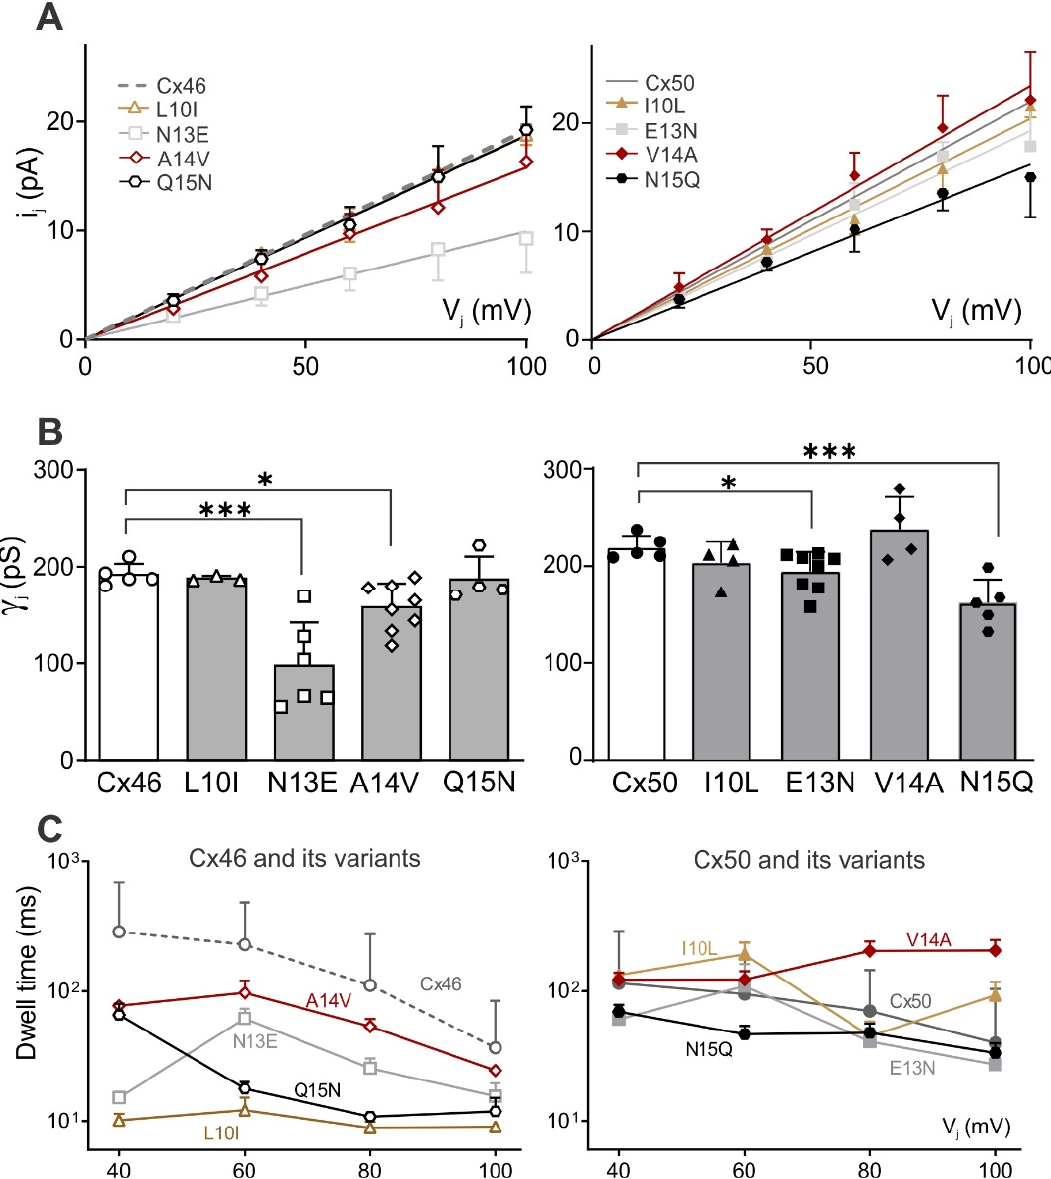
Figure 8. Unitary channel properties of homotypic GJs of Cx46 L10I, N13E, A14V, Q15N and Cx50 I10L, E13N, V14A, N15Q variants. ( A ) Plot of averaged i j amplitudes at the main open state for the tested V j s. Linear regression was used to obtain the slope which represents the slope unitary channel conductance ( γ j ) for each variant. The dashed and solid gray lines represent the slope γ j s of Cx46 and Cx50, respectively. The slope γ j of Cx46 L10I is 188 ± 6 pS (n = 3), N13E γ j is 93 ± 17 pS (n = 6), A14V γ j is 94 ± 11 pS (n = 6), Q15N γ j is 187 ± 10 pS (n = 4), Cx50 I10L γ j is 204 ± 10 pS (n = 4), E13N γ j is 193 ± 17 pS (n = 8), V14A γ j is 234 ± 12 pS (n = 4), and N15Q γ j is 162 ± 14 (n = 5). ( B ) Bar graphs for direct comparison of slope γ j s of tested Cx46 (left panel) and Cx50 (right panel) variants. Cx46 N13E and A14V as well as Cx50 E13N and N15Q showed significantly lower γ j compared to their corresponding wild-type. Kruskal–Wallis test followed by Dunn’s test was used to compare each variant to its corresponding wild-type. ( C ) Average open dwell time for each GJ was plotted at different V j s. The number of events analyzed ranged from 25 to 637 from two to nine cell pairs. Note that the open dwell time is plotted on a logarithmic scale to show large differences among these GJs. * p < 0.05; *** p <